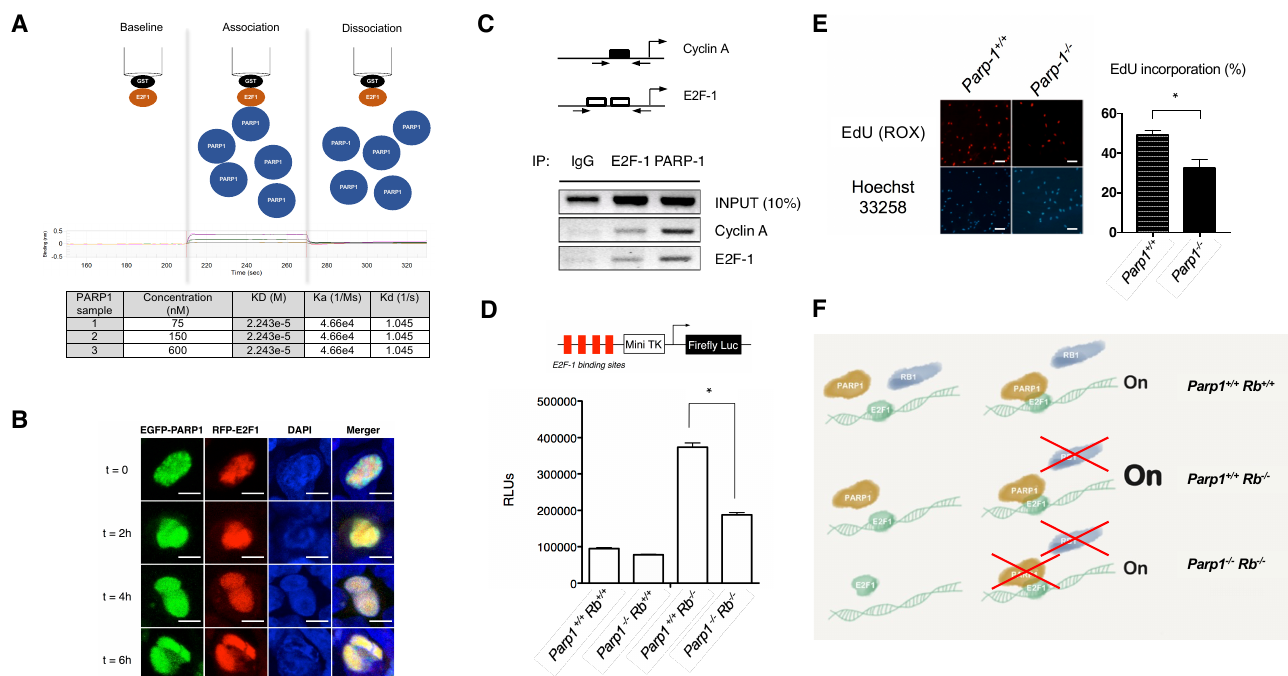
Figure 4. PARP1 interacts with E2F1 and fine-tunes its biological activity. ( A ) Biolayer Interferometry (BLI) analysis of the E2F1 and PARP1 interaction. ( B ) HEK 293 cells transfected with equimolar quantities of EGFP-PARP1 and RFP-E2F1 were blocked in G1 / S by double double-thymidine treatment. Representative laser scanning confocal microphotographs of co-localization of both proteins show the spatial correlation of PARP1 and E2F1 in the nucleus at di ff erent times after block release. Scale (100 × ) = 10 µ m. ( C ) Chromatin immunoprecipitation of PARP1 reveals that the physical interaction between PARP1 and E2F1 occurs in E2F1 binding elements located in the promoters of E2F1 transcriptional targets. ( D ) Genetic deletion of Parp1 alleviates the transcriptional hyperactivation of E2F1 caused by the absence of retinoblastoma. Primary fibroblasts from Parp1 +/+ Rb +/+ , Parp1 +/+ Rb − / − , Parp1 − / − Rb +/+ , and Parp1 − / − Rb − / − mice were transfected with the E2F-Luc reporter vector and pCMV − β − Gal. Transactivation e ffi ciency is expressed as relative luciferase units normalized to β − Galactosidase activity (* p < 0.05). ( E ) EdU incorporation in Parp1 − / − or Parp1 +/+ cells. Scale (20 × ) = 25 µ m (* p < 0.05). ( F ) Schematic representation of the role of PARP1 on E2F1 transcriptional function. PARP1 is a transcriptional co-activator of transcription of E2F1-regultated genes. When a loss of RB function occurs, the lack of the inhibitory e ff ect of RB on E2F1-driven transcription results in increased activity that is favoured by the presence of PARP1. Concomitant loss of PARP-E2F1 interaction alleviates the consequences of the lack of RB, thus reducing the transcriptional activity of